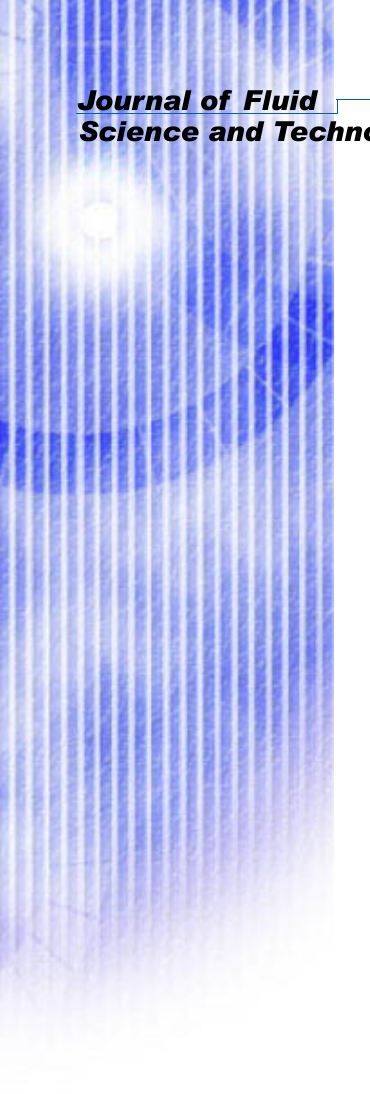
Fig. 1 Schematic diagram and coordinate system Fig 2. Evolution of normalized azimuthal